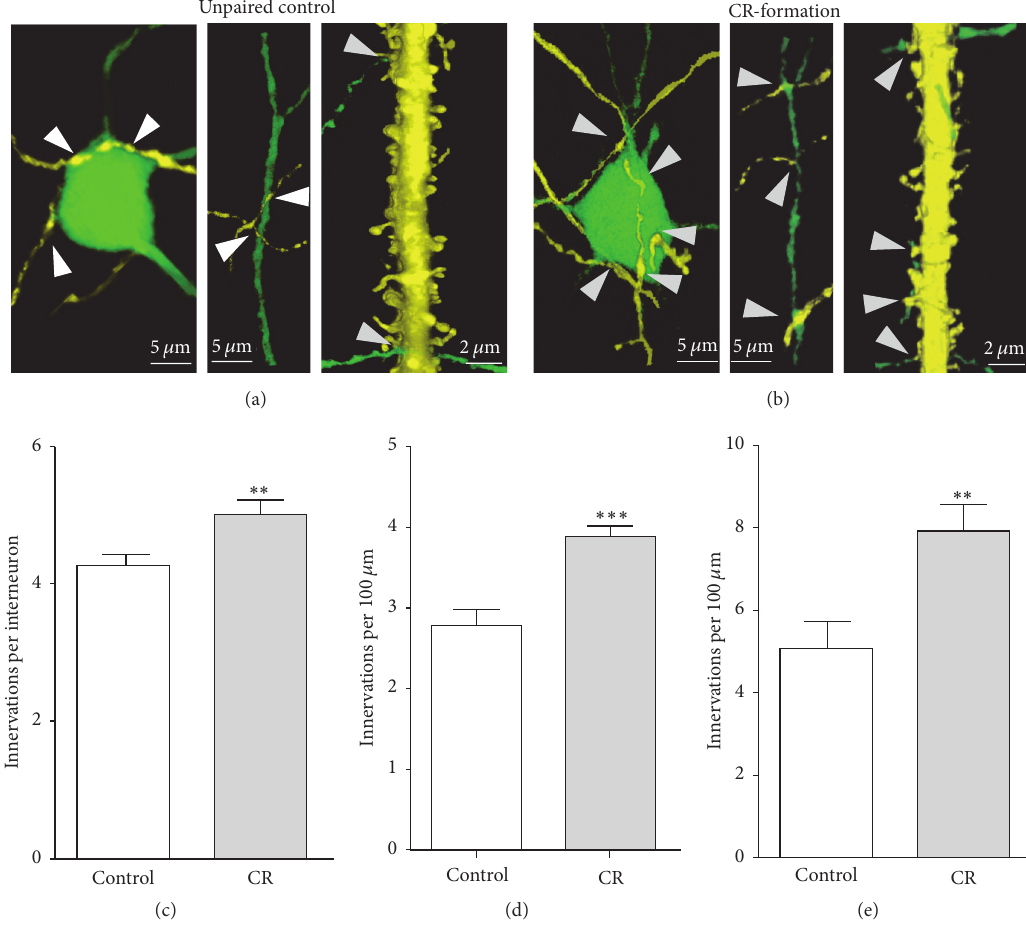
Figure 9: Mutual innervation between excitatory and inhibitory neurons is upregulated after associative learning. (a) shows YFP-labeled axon terminals on a GFP-labeled GABAergic neuron (left panel) and its process (middle) as well as GFP-labeled axon terminals on YFP- labeled apical dendrite of a glutamatergic neuron (right) from controls. (b) shows YFP-labeled axon terminals on a GFP-labeled GABAergic neuron (left panel) and its process (middle) as well as GFP-labeled axon terminals on YFP-labeled dendrite of a glutamatergic neuron (right) from CR-formation. White arrows indicate their termination. (c) shows YFP-labeled axon terminals on each GABAergic neuron in control (white bar) and CR-formation (gray, two asterisks, 𝑝 < 0.01 , 𝑛 = 43 ). (d) shows YFP-labeled axon terminals per 100 𝜇 m GFP-labeled dendrite of GABAergic neurons in controls (white bar) and CR-formations (gray, three asterisks, 𝑝 < 0.001 , 𝑛 = 26 ). (e) shows GFP-labeled axon terminals per 100 𝜇 m YFP-labeled apical dendrite of glutamatergic neurons in controls (white bar) and CR-formations (gray, two asterisks, 𝑝 < 0.01 , 𝑛 = 19